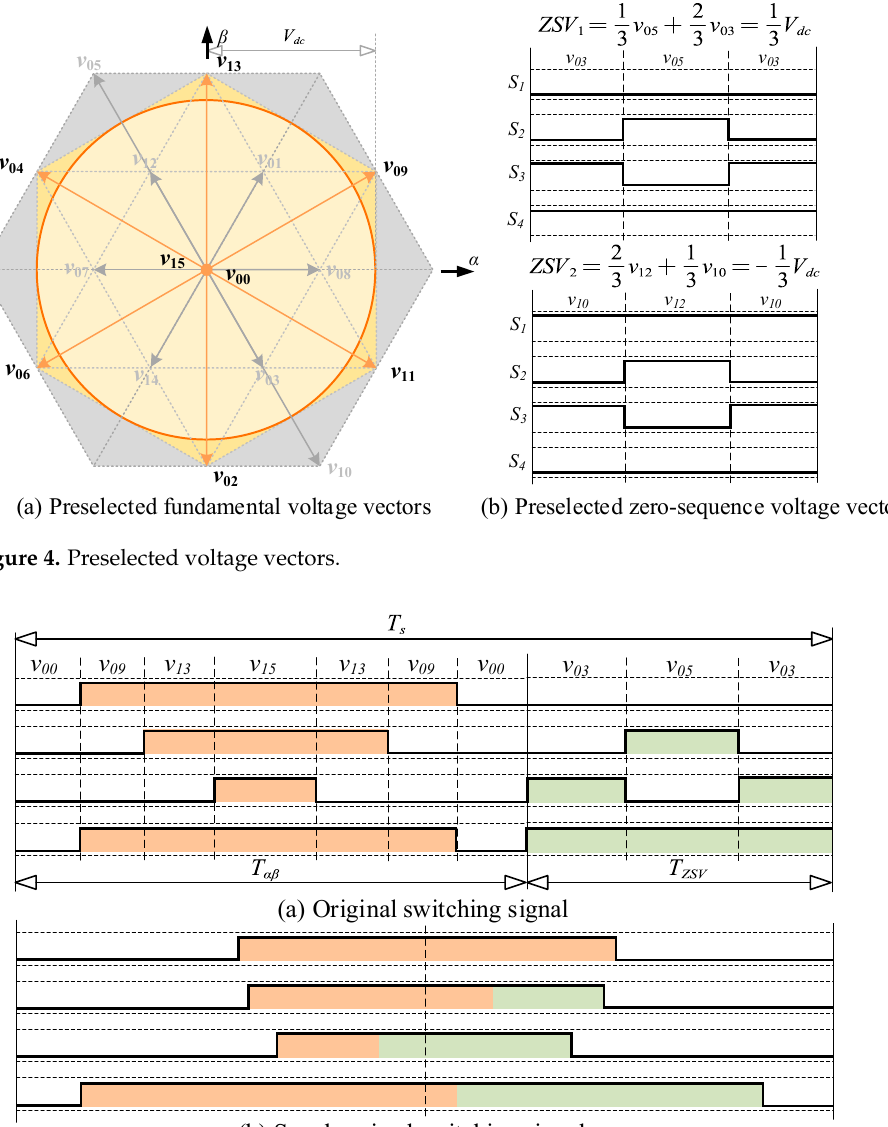
Figure 5. Switching signal centralization.